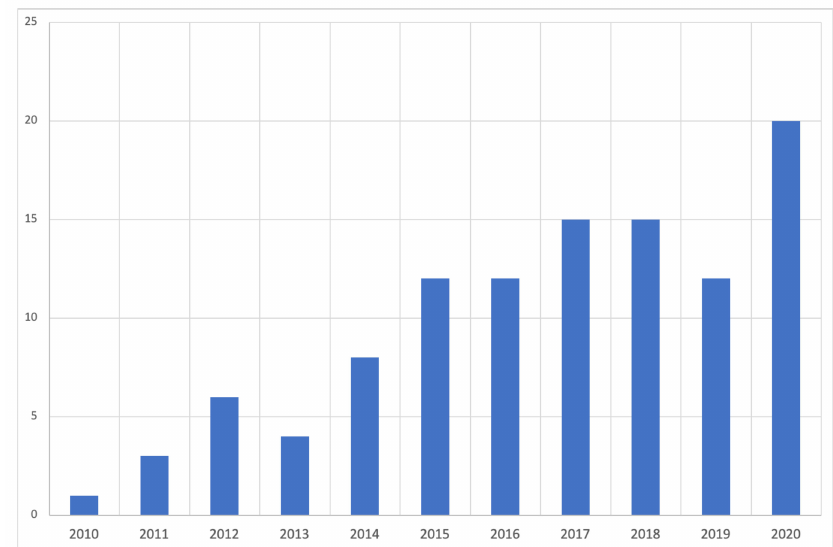
Figure 2. Year of publication analysis for initial search timeline